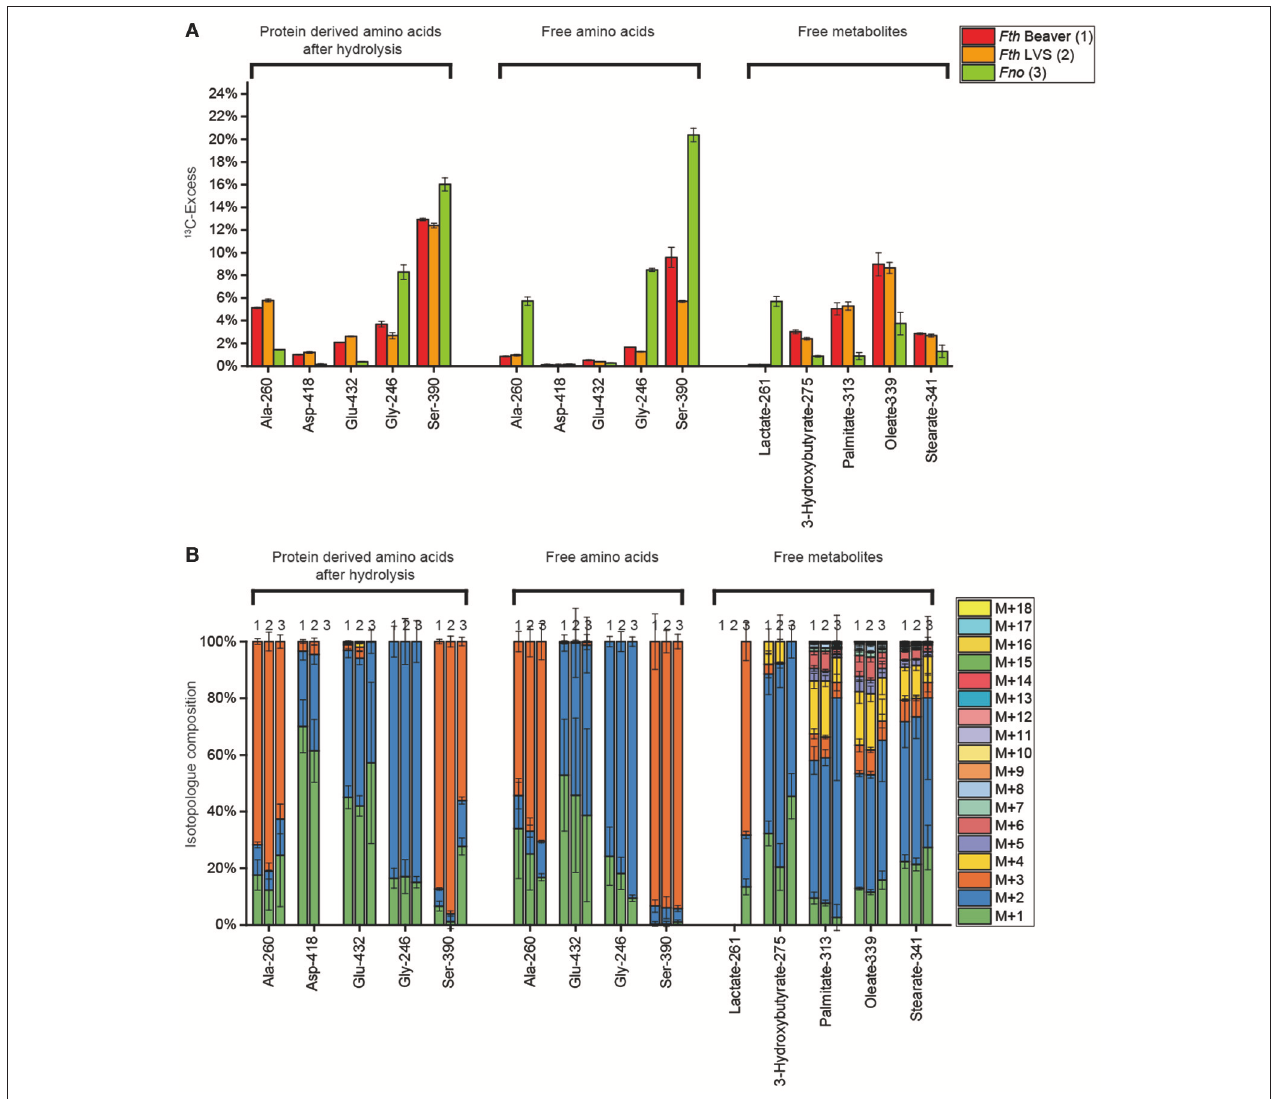
FIGURE 4 | (A) 13 C-Excess (mol%) and (B) the fractional isotopolog distributions (%) in key metabolites of Fth Beaver (1), Fth LVS (2), or Fno (3) grown in medium T supplied with 3 mM [U- 13 C 3 ]serine. For numerical values, see Supplemental Tables S3, S7, S11, S15, S19, S23. For more details, see also legend to Figure 2